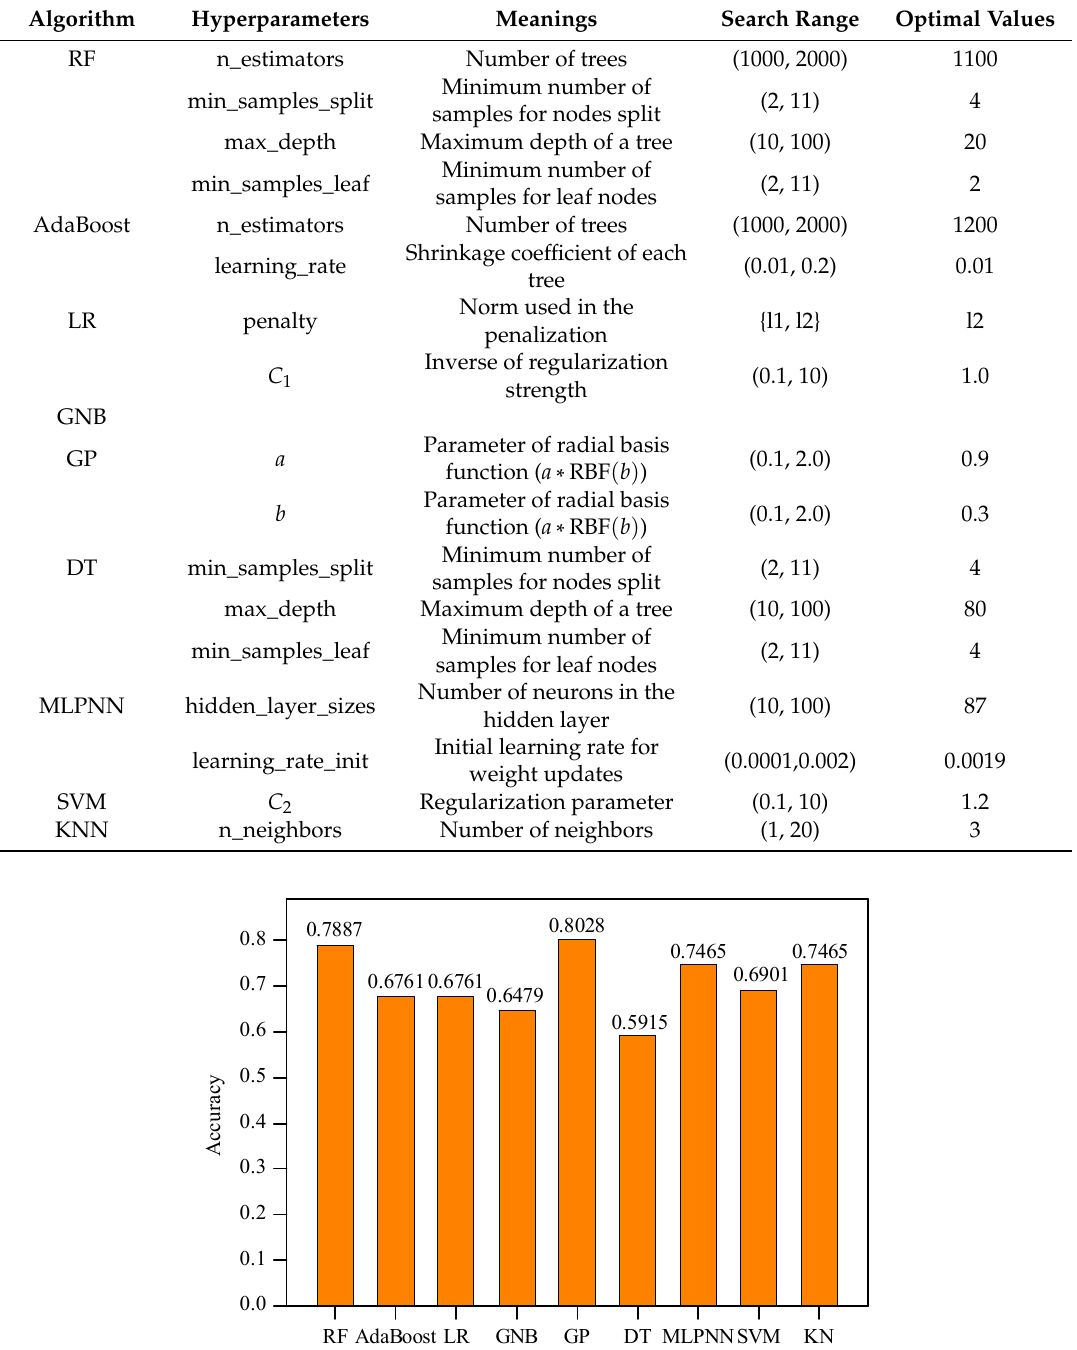
Table 6. Hyperparameters optimization of comparison algorithms.